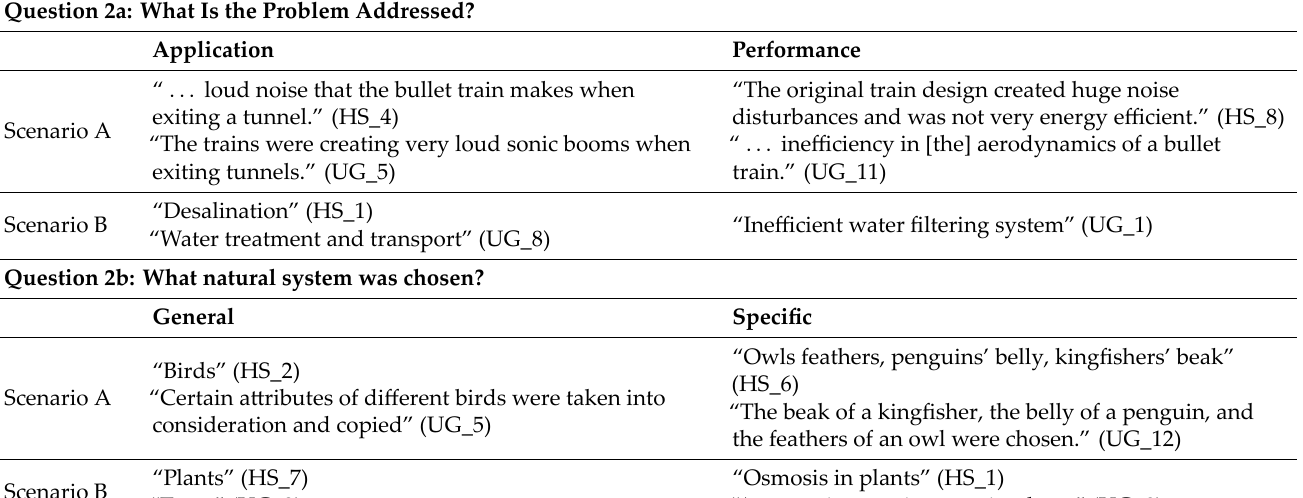
Table 5. Answers to Questions 2a, 2b, and 2c. Examples of answers provided are given, and student IDs are indicated in